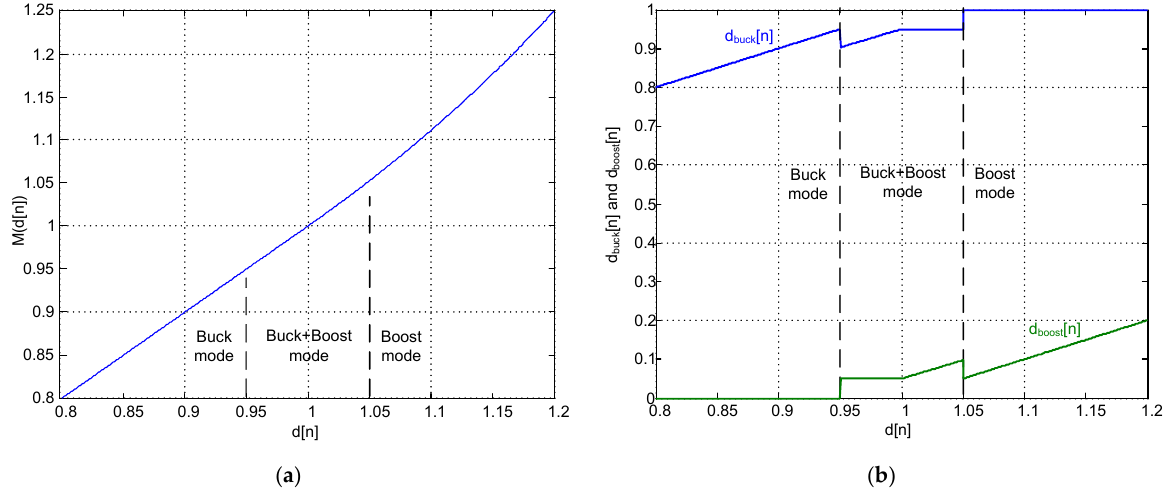
Figure 10. ( a ) Representation of the conversion ratio M(d[n]). ( b ) (d buck [n],d boost [n]) pairs to obtain a smooth transition between modes.